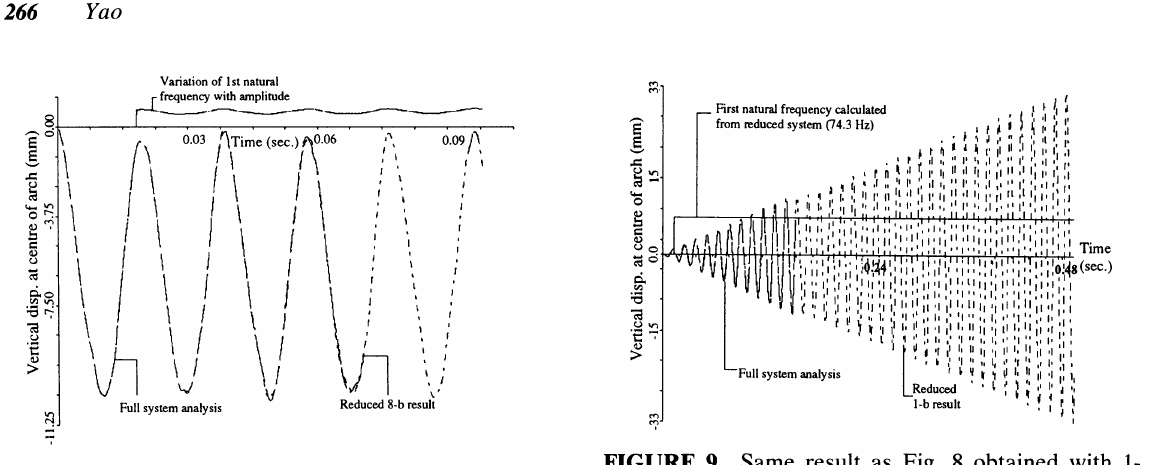
FIGURE 9 Same result as Fig. 8 obtained with 1- basis reduced